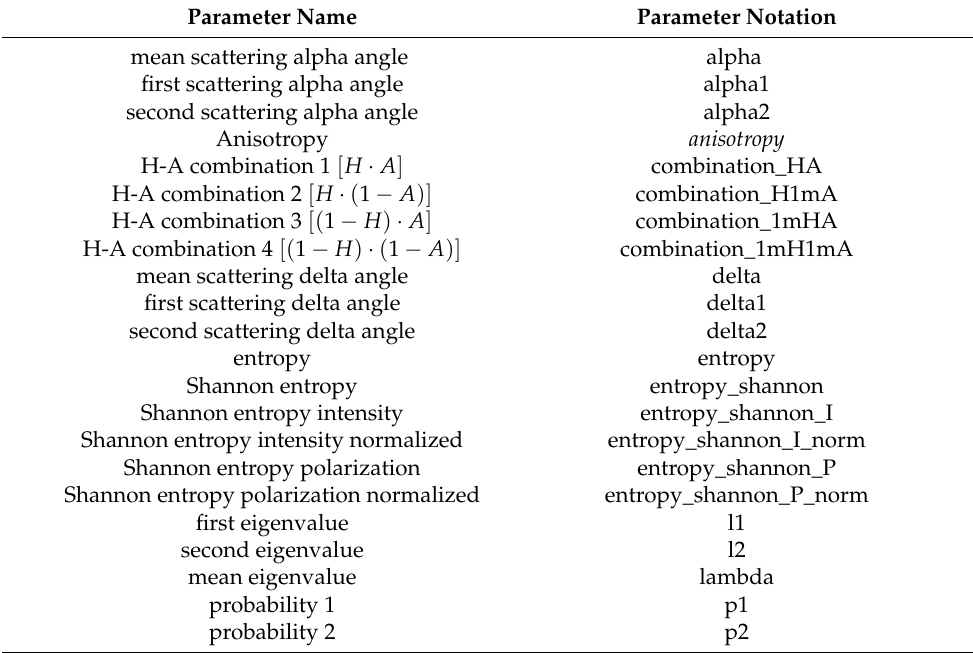
Table 1. Summary of H/A/ α polarimetric